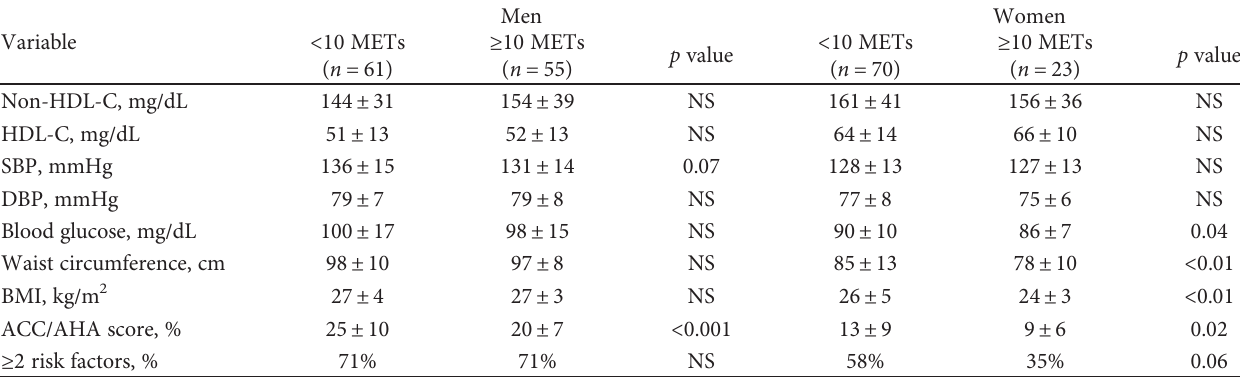
Table 4: Biochemical and anthropometrical variables according to aerobic capacity in subjects 65 years and older.